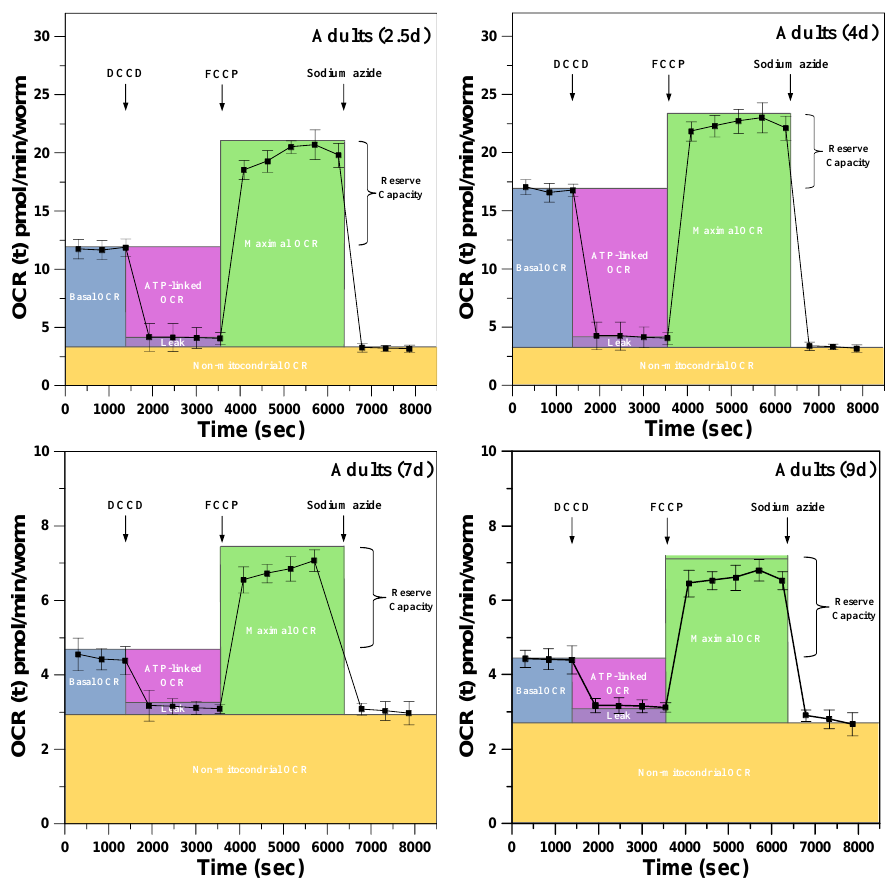
Figure 6. The representative results of the metabolic profiles of a single developing C. elegans at ages of 2.5, 4, 7, and 9 days obtained by sequentially adding metabolic inhibitors (DCCD, FCCP, and sodium azide) to block bioenergetic pathways. The metabolic profiles show the following fundamental parameters: basal OCR (blue), ATP-linked OCR (pink), maximal OCR (green), reserve respiratory capacity, OCR due to proton leak (purple), and non-mitochondrial OCR (yellow). (Mean ± SEM; n = 3).